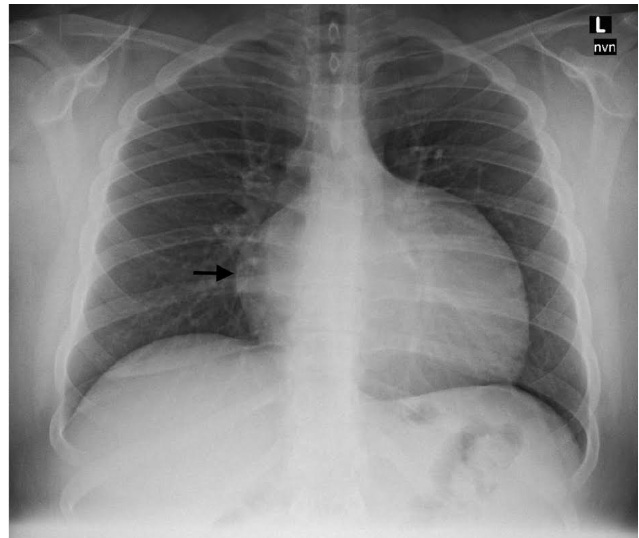
Figure . Chest radiograph showing enlarged cardiomediastinal silhouette with narrow vascular